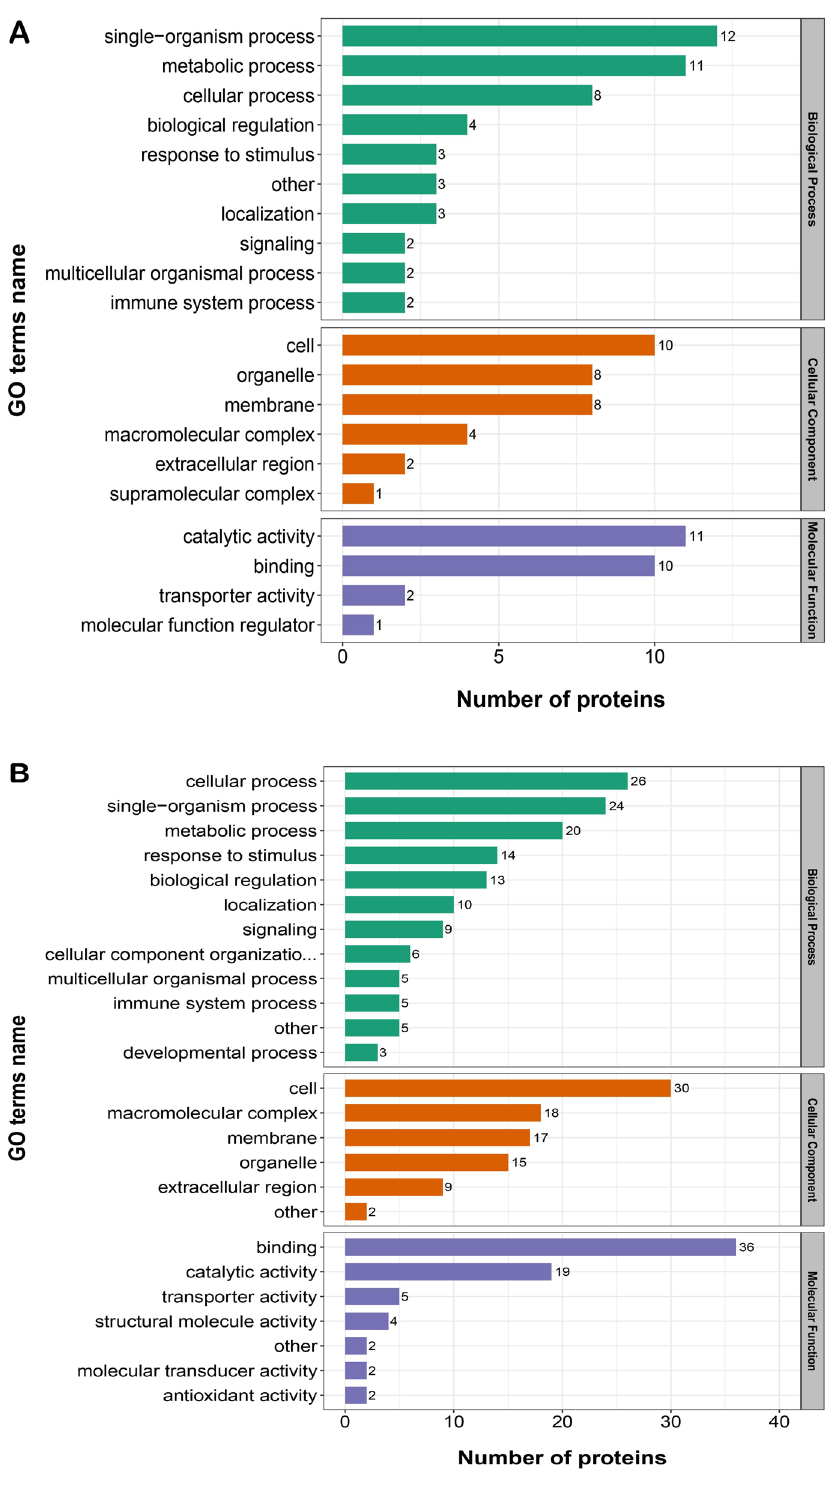
Figure 5. Statistical distribution chart of differentially abundant proteins (DAPs) under each Gene Ontology (GO) category in each comparison group. ( A ) S2 vs S1; ( B ) S3 vs S1; ( C ) S4 vs S1. The horizontal coordinate represents the number of proteins. The vertical coordinate represents the GO terms. S1: control diet; S2: control diet supplemented with 1 μg/kg 1α,25(OH) 2 VD 3 ; S3: control diet supplemented with 2 μg/kg 1α,25(OH) 2 VD 3 ; S4: control diet supplemented with 4 μg/kg 1α,25(OH) 2 VD 3. 1α,25(OH) 2 VD 3 was provided as 1α,25(OH) 2 VD 3 - glycosides from plant